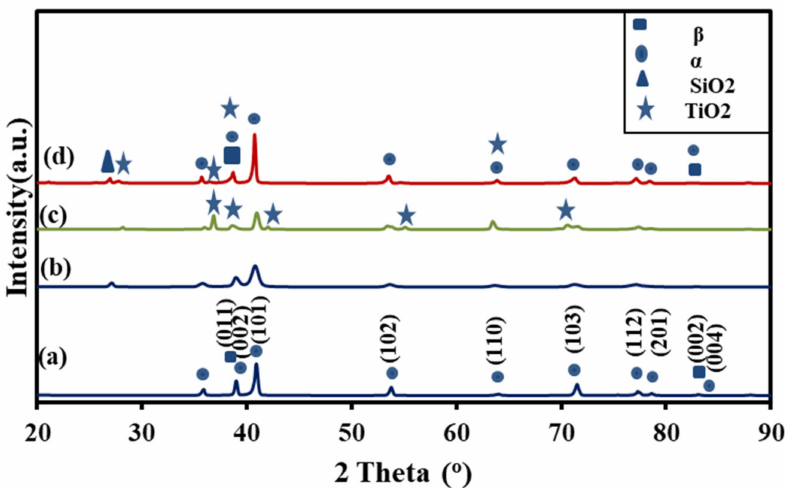
Figure 1. XRD of Ti64 alloy pretreated and thermally treated at various conditions (a) M, (b) SB, (c) MT, (d)